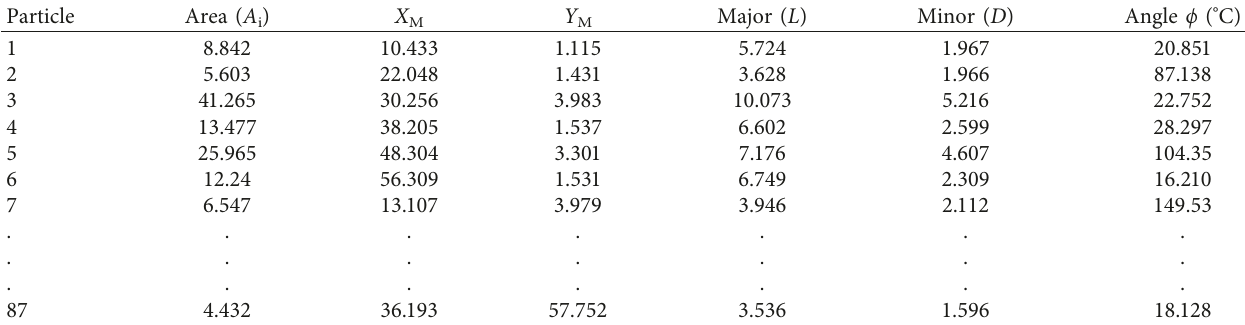
Table 4: Extract of data from image analysis of side 1 of the RVE of 60 × 60 × 60mm 3 (see Section 1 in Supplementary Material). Particle